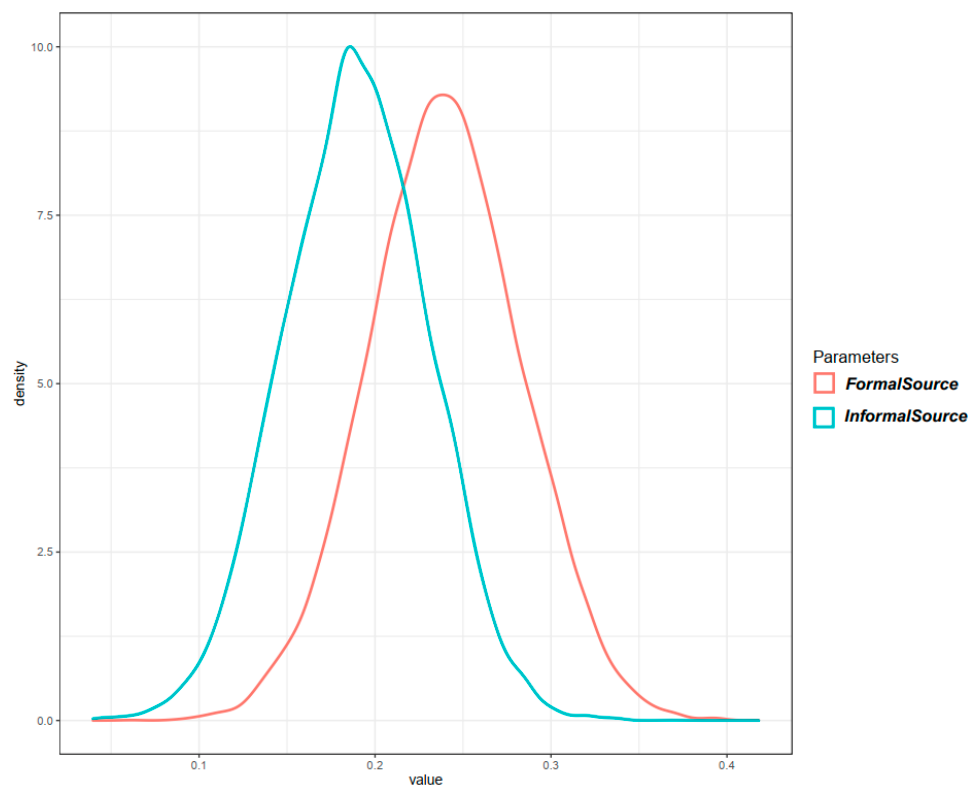
Figure 6. Model 2 ′ s posterior distributions on the density plot. Figure 6. Model 2’s posterior distributions on the density plot.